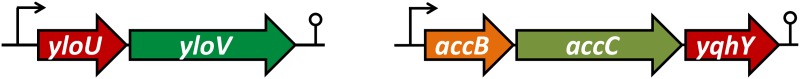
Genetic context of yqhY and yloU. The genes are located in two distinct operons together with genes encoding proteins involved in fatty acid metabolism. yqhY clusters with accB (biotin carboxyl carrier protein) and accC (biotin carboxylase subunit). yloU forms an operon with yloV.